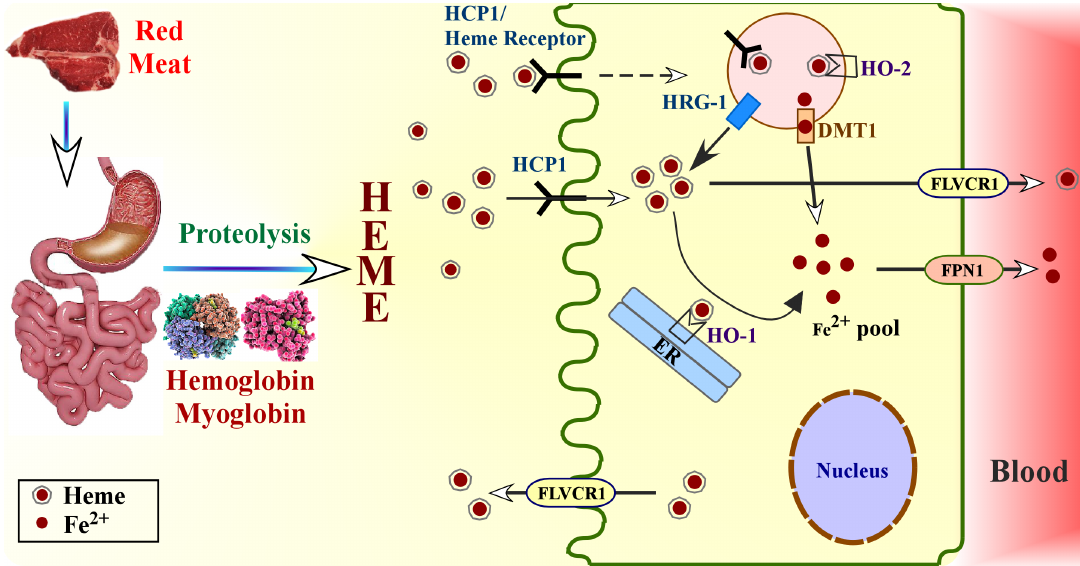
Figure 1. Heme absorption in gut from dietary proteins. Low pH of stomach releases heme-containing proteins hemoglobin and myoglobin from dietary meat. Heme is released by the action of proteases in stomach and intestine. Intake of heme into enterocytes can be facilitated by vesicular transport system when heme binds to heme transporter or heme receptor. Additionally, heme can be directly imported into the enterocytes by HCP1. Heme is transported to the cytoplasm from the vesicles possibly by HRG-1, and is then metabolized by HO-1 present on endoplasmic reticulum. Iron is released subsequently. Alternatively, heme inside the vesicles can be metabolized by the action of HO-2 present on vesicle membrane, and the released iron (Fe 2+ ) is transported into the cytoplasm by metal transporter DMT1 to join the common pool of iron in the cytoplasm. Elemental iron is released into the blood stream by the enterocytes via ferroportin present on the basolateral membrane. A fraction of intact heme can be released directly into the blood stream via heme transporter FLVCR1. FLVCR1 exports cytoplasmic heme, and it can export heme into the lumen during increased cellular heme content to protect from heme toxicity. HCP1, heme carrier protein 1; HRG-1, heme responsive gene-1; FLVCR1, cell surface receptor for feline leukemia virus, subgroup C, cellular receptor 1; HO-1/2, heme oxygenase-1/2; DMT1, divalent metal transporter 1; FPN1, ferroportin-1; ER, endoplasmic